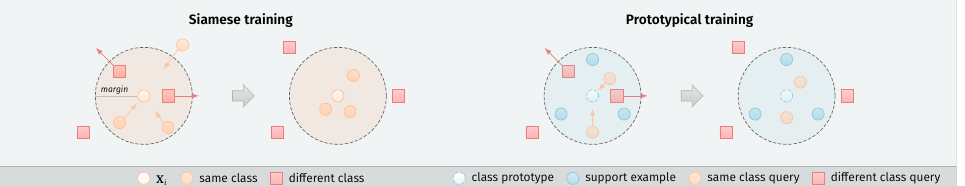
Figure 3. Overview of the Siamese and prototypical training approaches. Siamese networks use a contrastive loss to make pairwise comparisons between examples from the dataset X . Examples from the same class are attracted to each other, while the examples from different classes are pushed back if their distance is lower than the defined margin m . The prototypical approach uses additional support examples S . Their mean vector defines the class prototype. Query examples Q of the same class are attracted to this prototype, while queries of different classes are pushed back in the same way as with Siamese